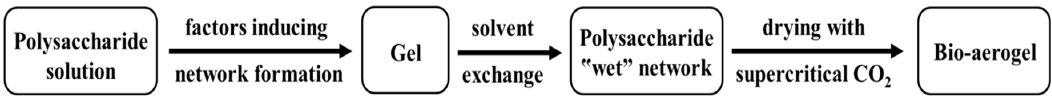
Figure 1. General pathway of synthesis of bio-aerogels from polysaccharide solutions via several steps, including a gelation step, an exchange of the solvent fluid and eventually supercritical drying with carbon dioxide.